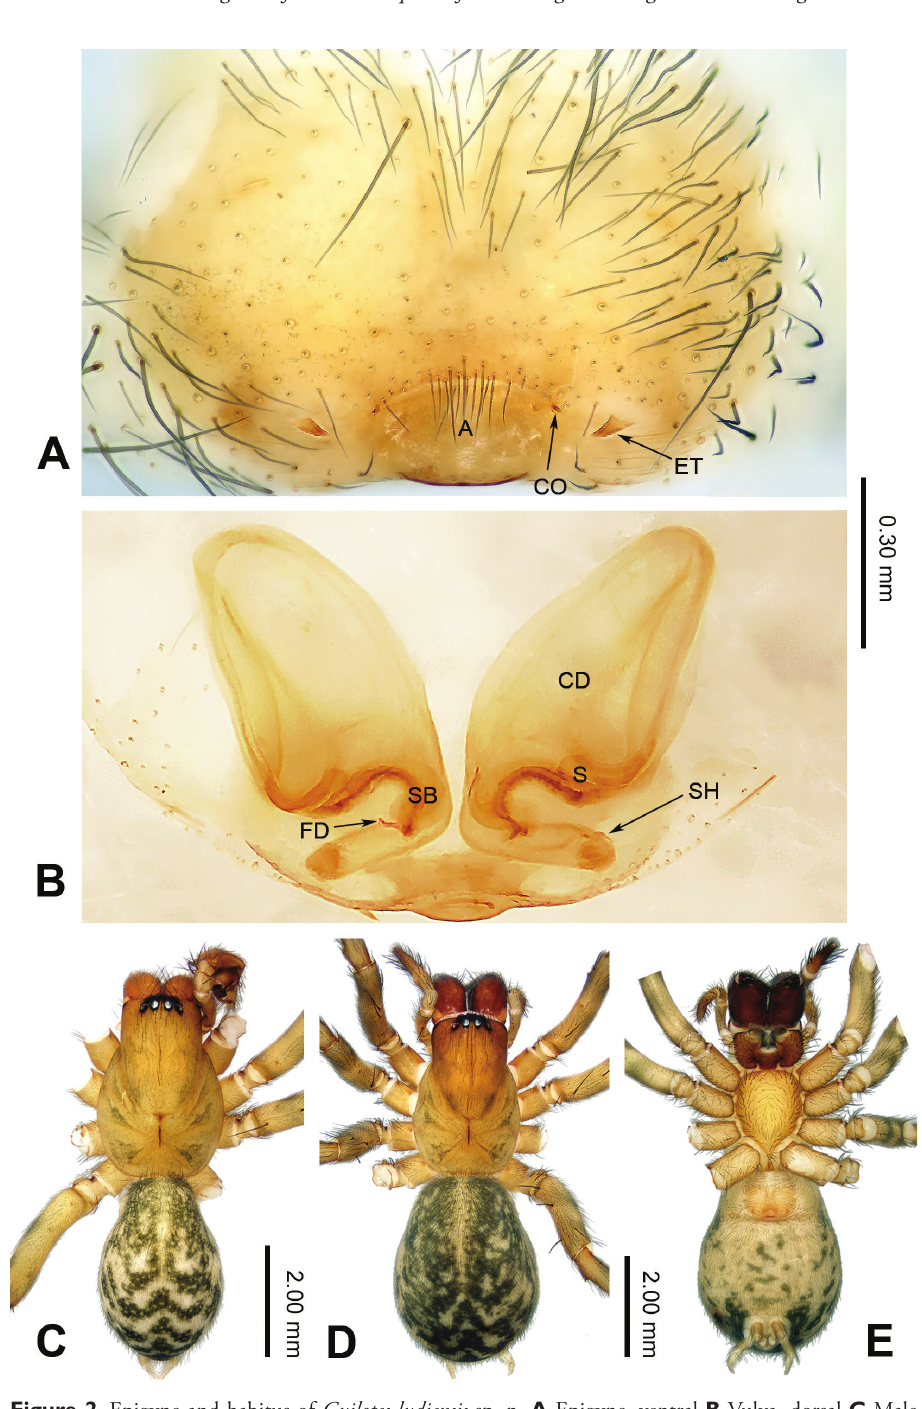
Figure 2. Epigyne and habitus of Guilotes ludiensis sp. n. A Epigyne, ventral B Vulva, dorsal C Male habitus, dorsal D Female habitus, dorsal E Female habitus, ventral. Scale bar equal for D and E